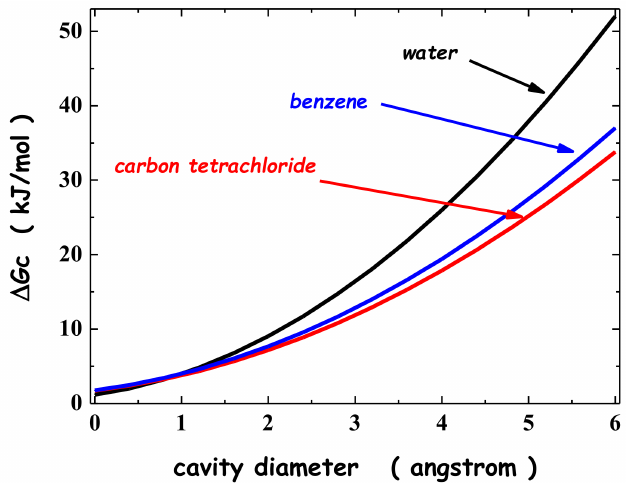
Figure 1. Trend of ∆ G C versus the cavity diameter for water, CCl 4 , and C 6 H 6 calculated by means of classic SPT, at 25 ◦ C and 1 atm. The data necessary to perform the calculations are reported in the notes of Table